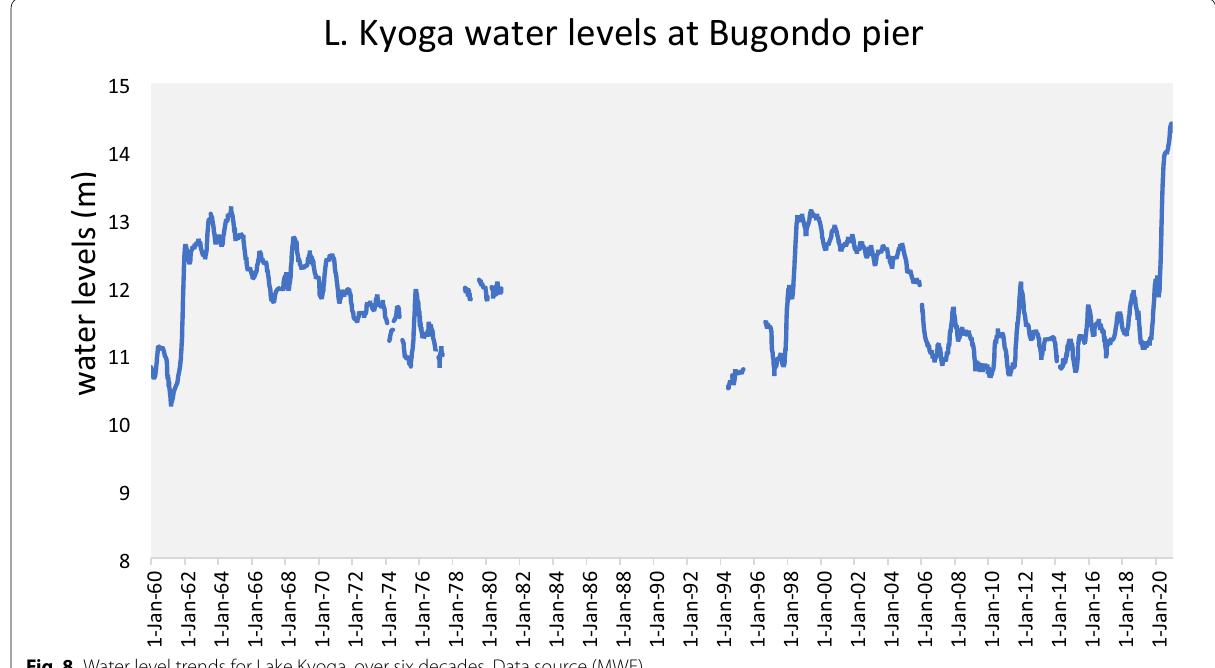
Fig. 8 Water level trends for Lake Kyoga, over six decades. Data source